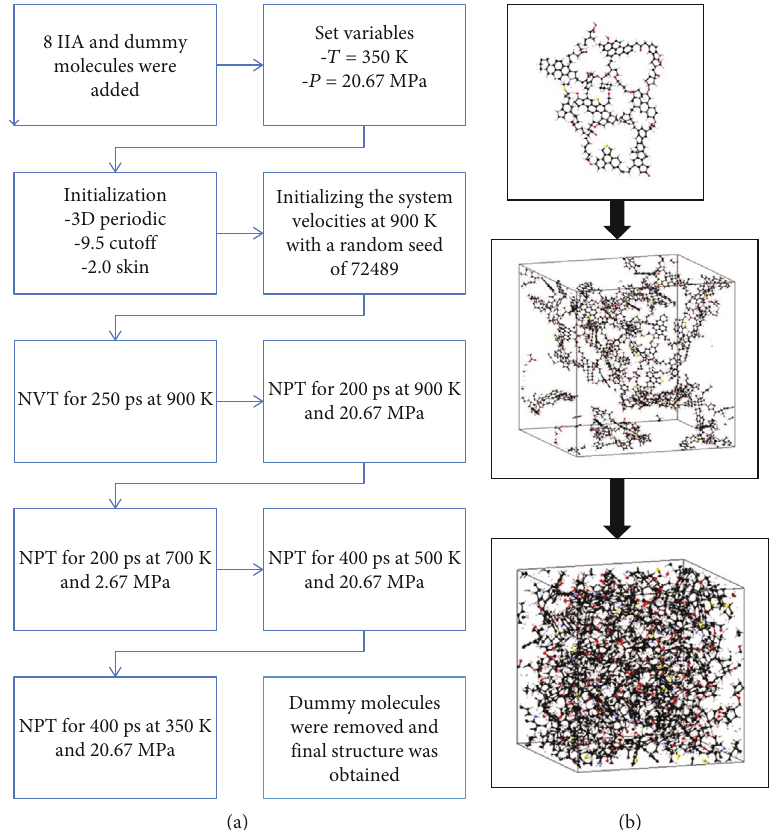
Figure 1: (a) LAMMPS protocol work fl ow for creating kerogen nanostructures. (b) from a single kerogen unit to the fi nal kerogen structure [82]. Table 1: Kerogen prototypes presented by Ungerer [58], reproduced from Alafnan [82]. Kerogen